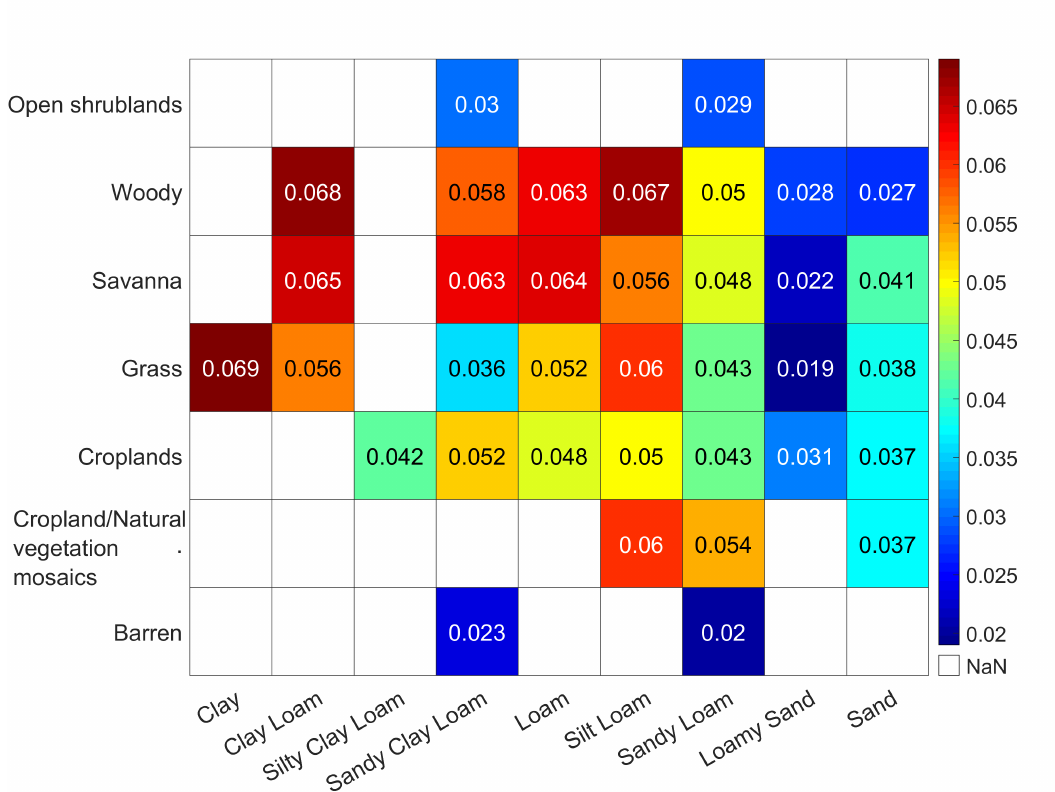
Figure 10. SM prediction performance (ubRMSE value) comparison for varying soil texture and land cover